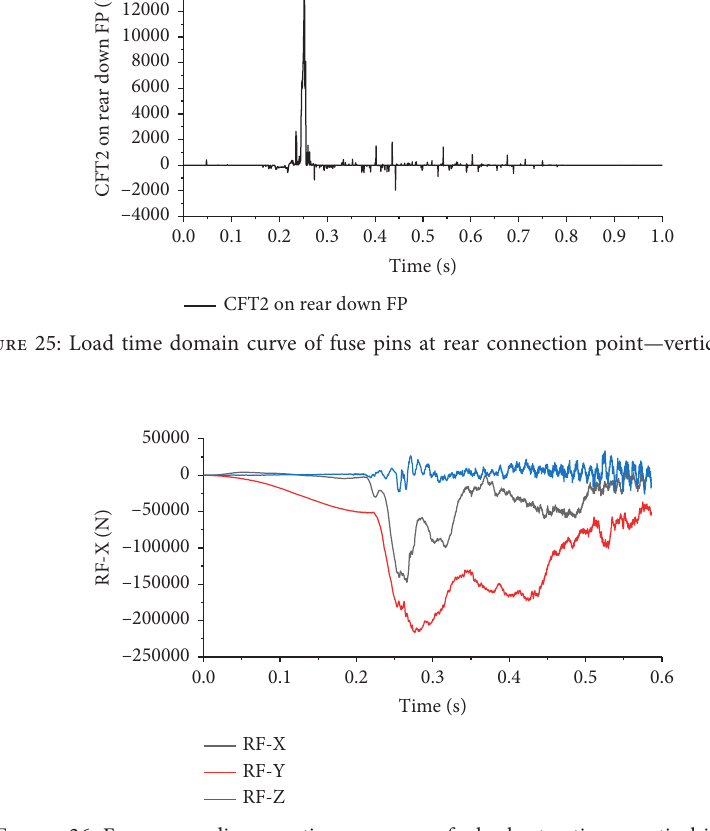
Figure 26: Emergency disconnection sequence of wheel retraction—vertical